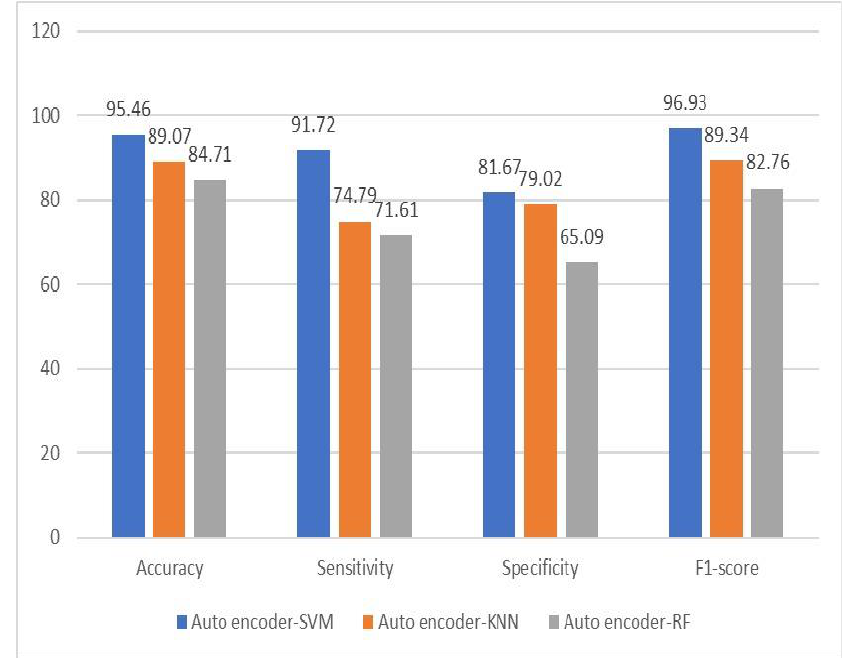
Figure 3. Performance parameters of the algorithms.